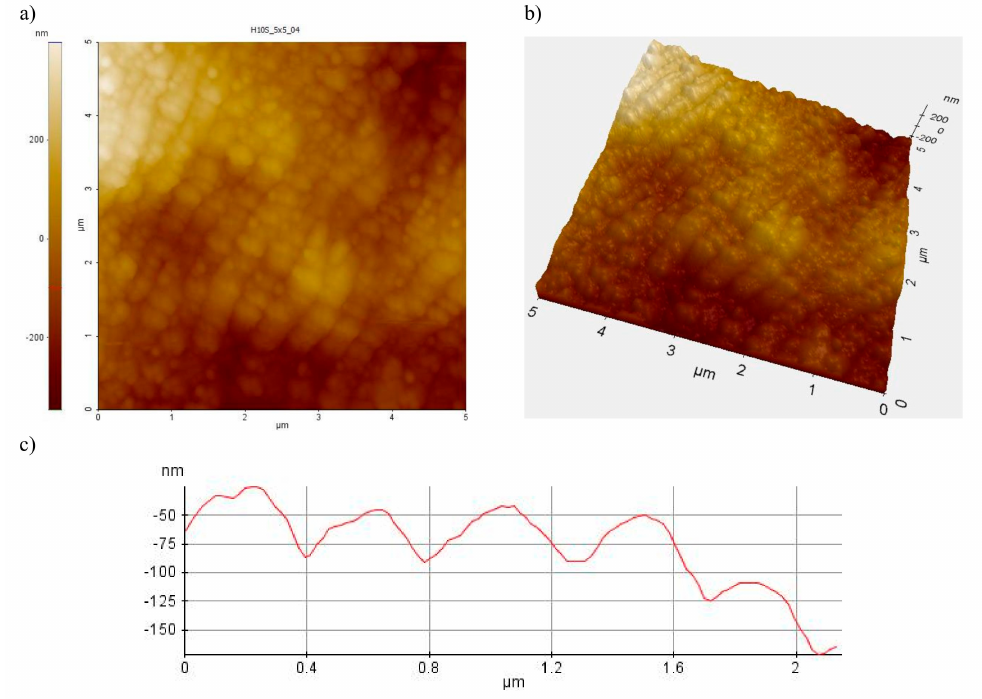
Figure 4. Nanoripples LIPSS ( a ) view two-dimensional (2D)-scan area 5 µ m × 5 µ m, ( b ) view three-dimensional (3D)-scan area 5 µ m × 5 µ m, ( c )